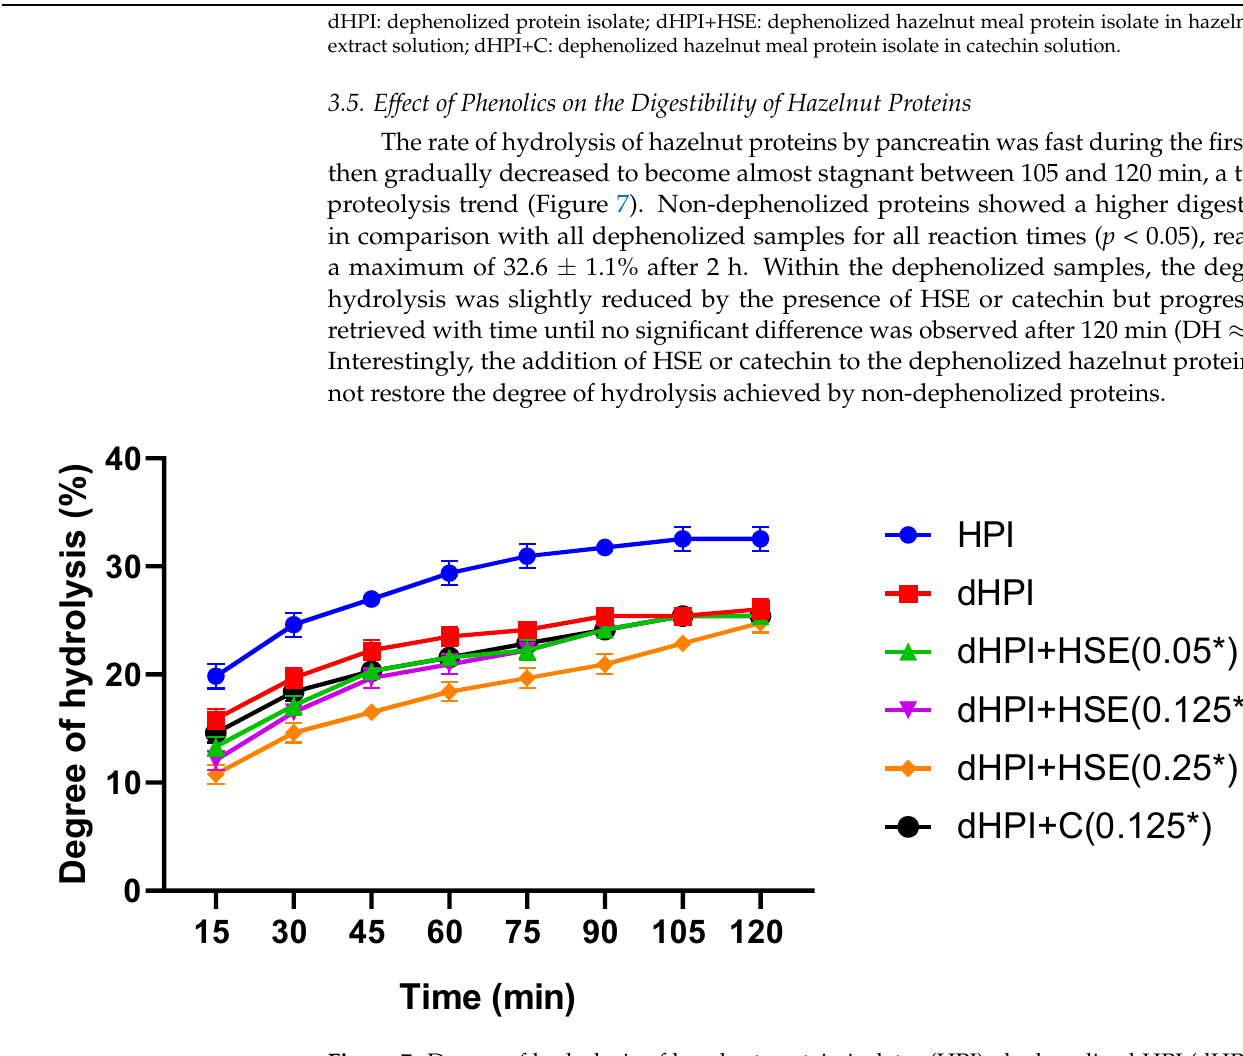
Figure 7. Degree of hydrolysis of hazelnut protein isolates (HPI), dephenolized HPI (dHPI), and dHPI+HSE/C complexes at different concentrations of phenolics (mM). * The actual concentrations were 16.67 times higher, but protein/phenolic ratios were kept the same as those in the other parts of the